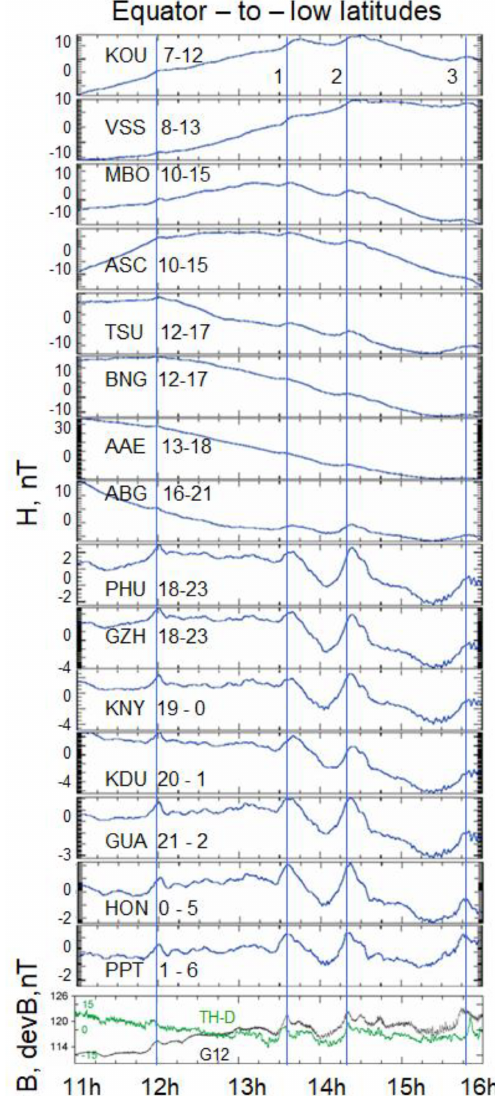
Figure 9. Relative variations in the horizontal component ( H ) of the geomagnetic field at low geomagnetic latitudes. Local time in- tervals are indicated near the station codes. The vertical lines depict magnetic peaks 1–3 at THEMIS (see Table 2). The bottom panel shows magnetic field B measured by GOES-12 (black) and the de- trended magnetic field from TH-D